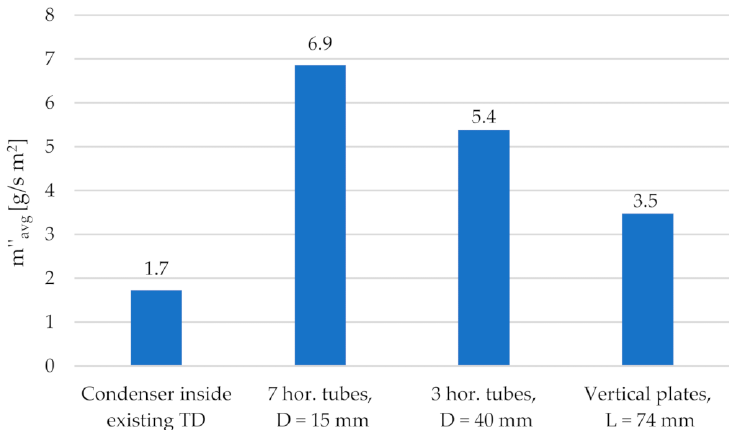
Figure A1. Comparison of condensation mass-flux rates of tube- and plate-based condensers with the condenser inside the condensation tumble dryer under real operating